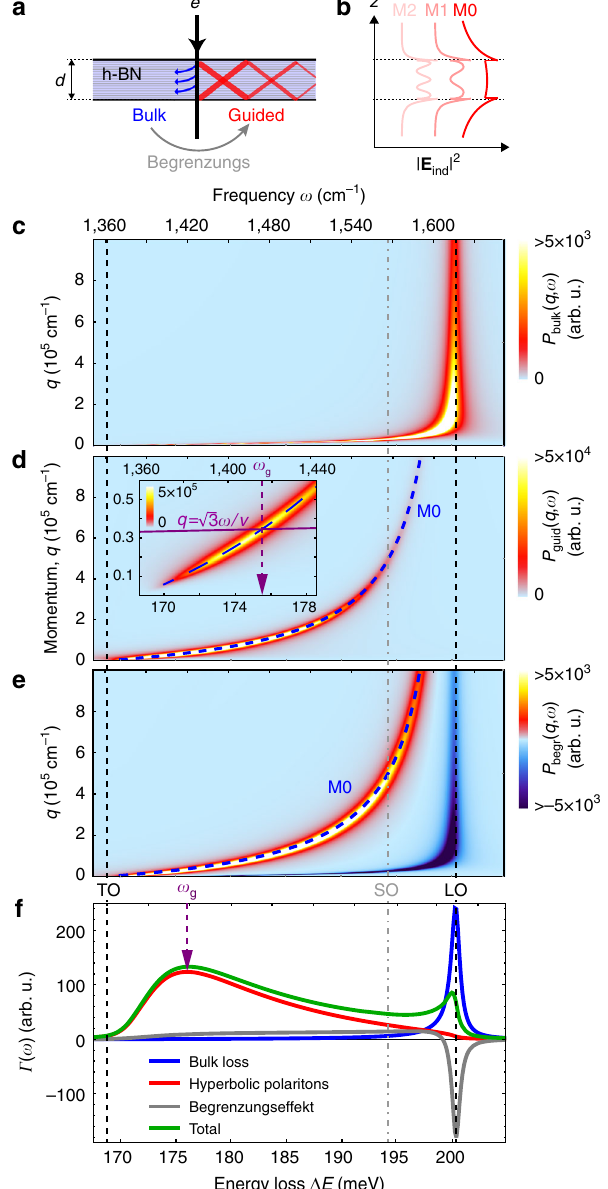
Fig. 3 Theoretical EEL probability spectrum of a homogeneous h-BN slab. a Schematic representation of the electron energy loss due to the excitation of the bulk phonon ( left ) and guided modes ( right ) in a dielectric slab. b Intensity pro fi les of three guided HPhP modes (M0, M1, and M2). c Energy- momentum map P bulk ( q , ω ) calculated for a 30-nm-thick h-BN slab. d Same as in c , but showing P guid ( q , ω ). e Same as in c , but showing P begr ( q , ω ). The dashed curves in d and e depict the dispersion of M0 mode of the hyperbolic phonon polariton (calculated according to the Supplementary Eq. (27)) 29 . Inset in d is a close up on P guid ( q , ω ) at low momenta; dashed purple arrow ffiffiffi p ω = v ( solid purple line , shows the energy ω g at which the line q ¼ 3 corresponding to the maximum of momentum transfer from electron to the guided mode) intersects with the M0-HPhP mode dispersion. f EEL probabilities, Γ ( ω ), corresponding to bulk ( blue ), guided-mode ( red ), Begrenzungseffekt ( gray ) losses and their sum ( green ). The vertical purple arrow marks the same energy as in the inset of d . In all plots, the vertical dashed lines mark the TO and LO phonon frequencies; vertical dot-dashed line marks the location of the SO energy (corresponds to ϵ ⊥ = −